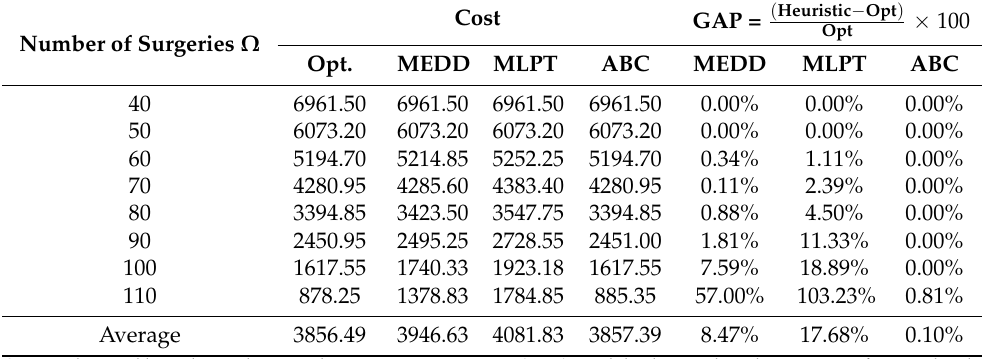
Table 2. The performance of the heuristics and the ABC algorithm for small problem instances.